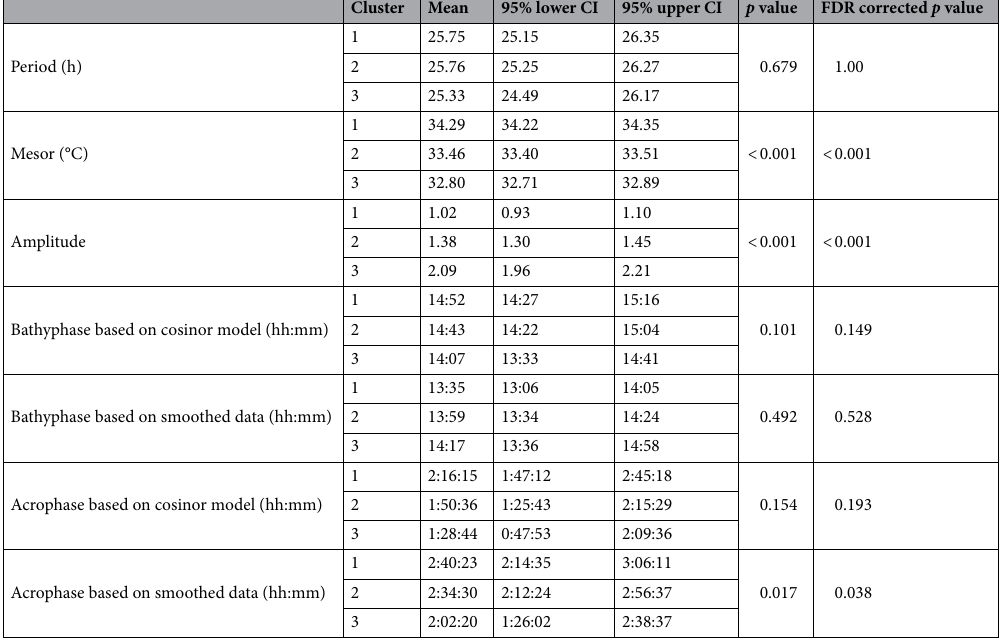
Table 2. Associations between clusters and Cosinor model parameters. Bathyphase and acrophase are presented in time units. Both cosinor model estimates and observed times from loess smoothed data are presented. Confidence intervals calculated using bias corrected bootstrapping with 1000 bootstrapped resamples. False discovery rate corrected p-values take account all omnibus analysis presented in article. CI confidence interval, FDR false discovery rate.